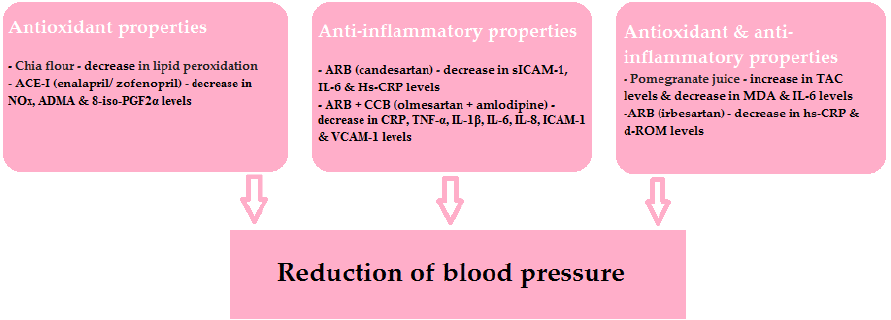
Figure 4. The beneficial effects of the discussed drugs and specific nutrients.